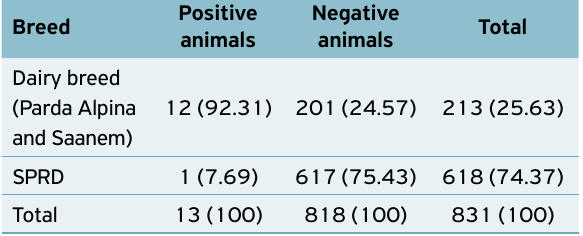
χ 2 =30.801; p<0.05.